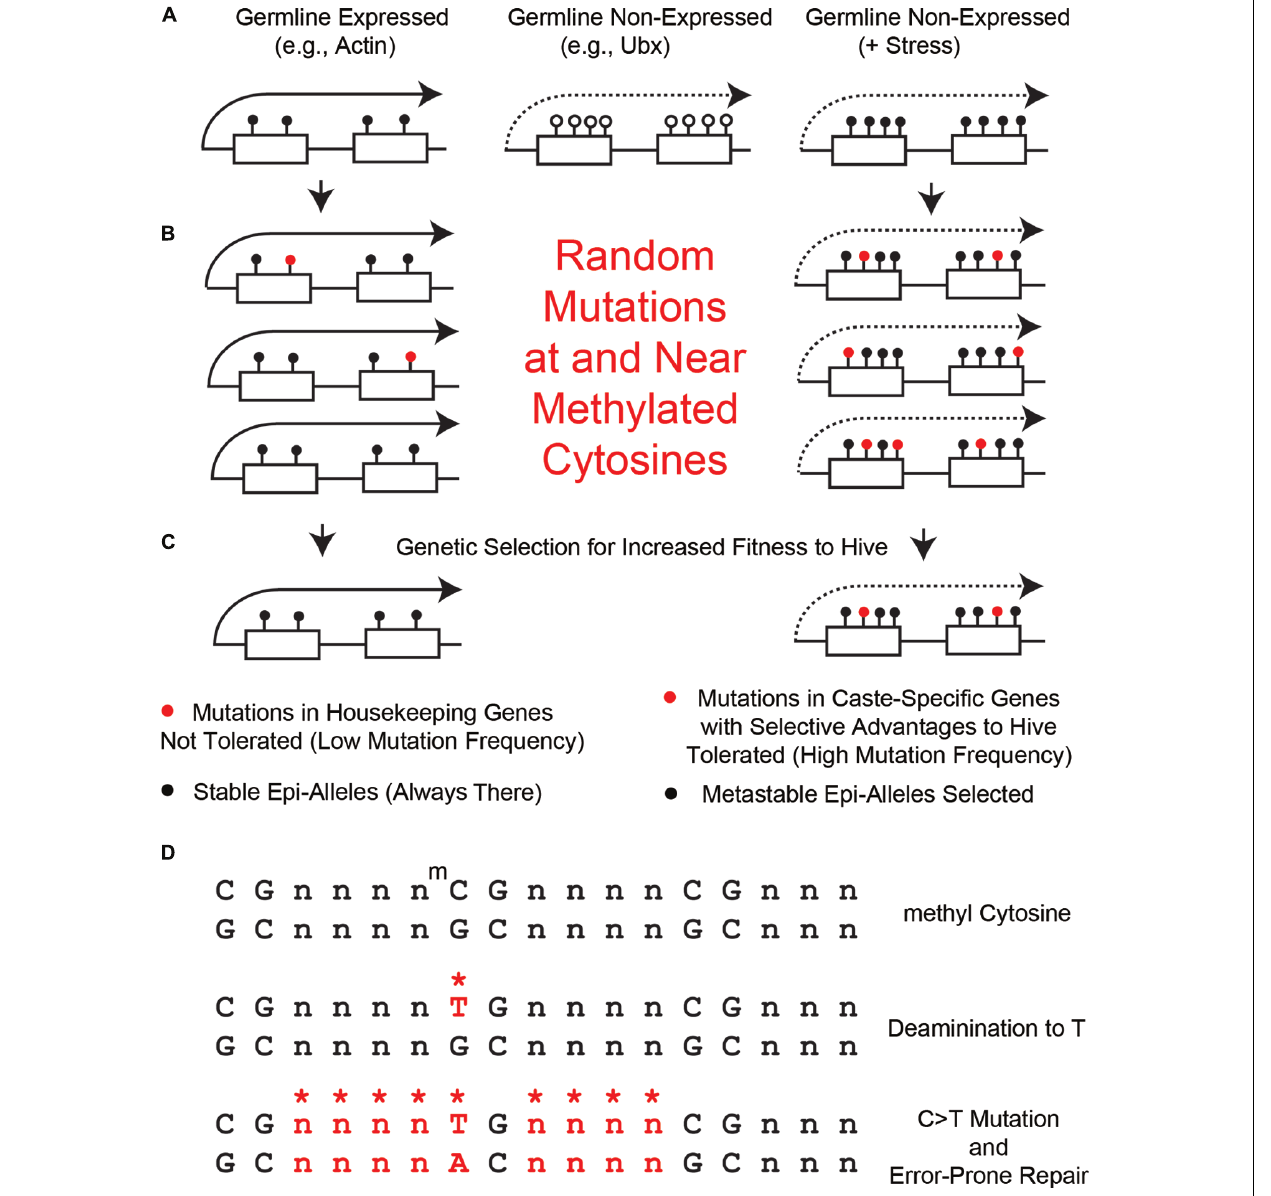
few CG s in high-expressed genes become mutated to TGs (red circles). Right, few 5mCs in the many CG s in poor-expressed stressed genes become mutated to TGs. (C) Left, mutations in high expressed genes get removed by purifying selection. Right, mutations in metastable epialleles remain because of low levels of purifying selection. (D) Mutations in bases near CG s (*n) can be generated by error prone DNA repair of 5mC > TG